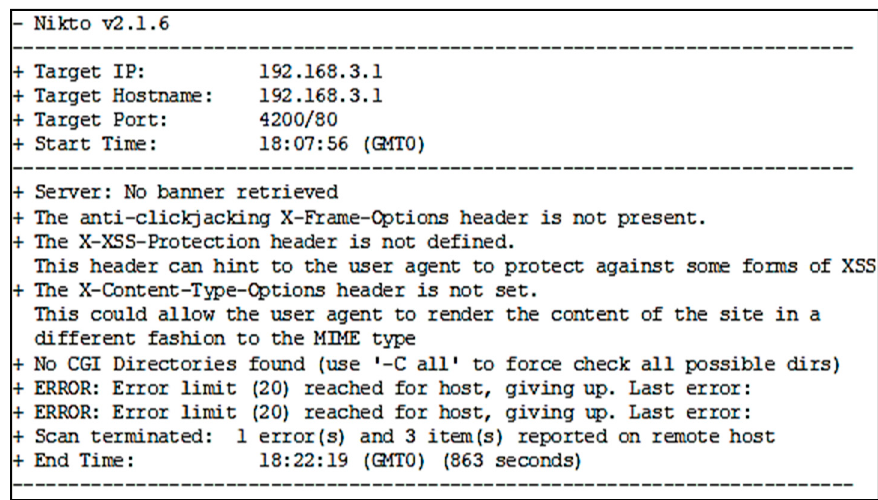
Figure 5. Webserver vulnerabilities (Nikto logs).